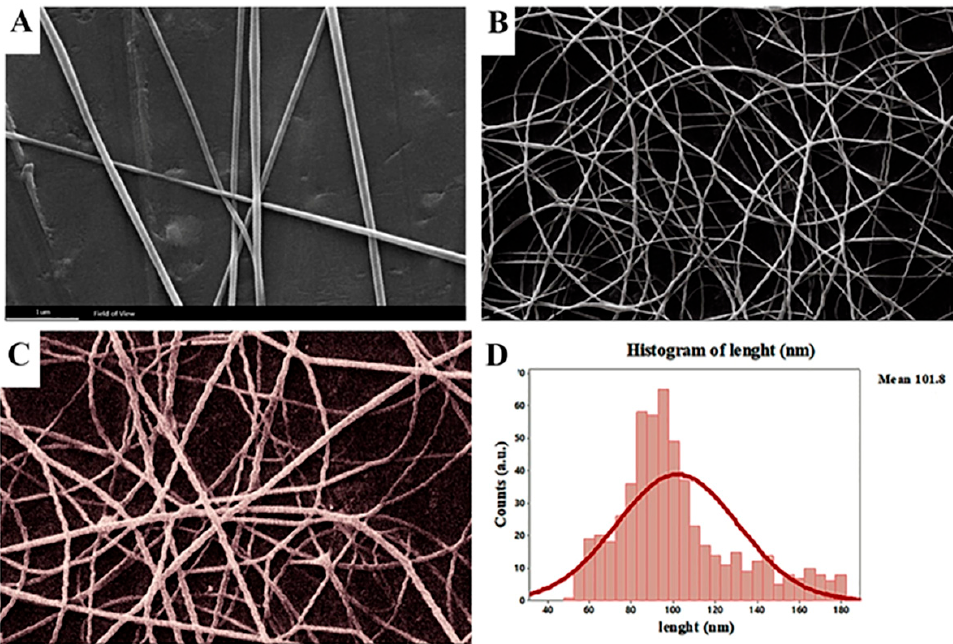
Figure 2. Electrospun PCL/CS/NS (mean diameter 81.19 ± 4.38 nm) in a SEM photograph: ( A ) PCL (1 μ m); ( B ) PCL/CS/NS (1 μ m); ( C ) PCL/CS/NS (500 nm); (D) The diameter size distributions.